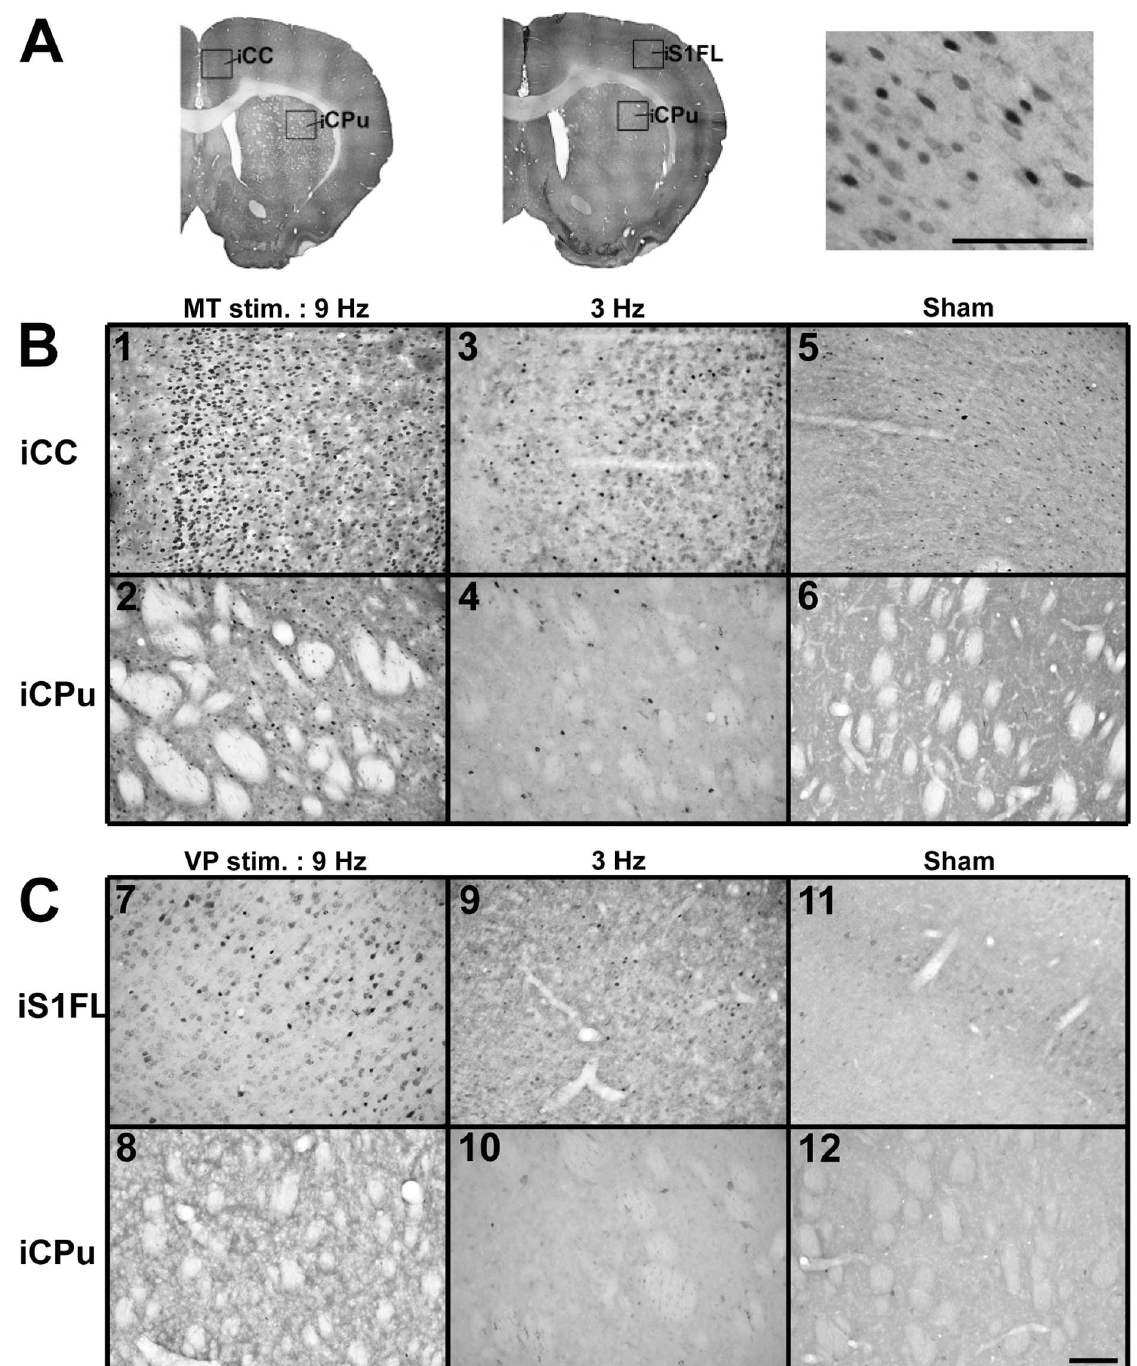
Figure 10. Photomicrographs depicting the distribution of Fos-immunoreactive cells in the brain regions of the iCC, iS1FL and iCPu after MT or VP stimulation. (A) Regions of interest where c-Fos labeled cells were counted. An example of the c-Fos labeled cells is shown in the right panel. (B) Show examples of the c-Fos labeled cells within iCC and iCPu with a 9-Hz (1,2) MT stimulation compare to 3-Hz stimulation (3,4) and sham control (5,6). (C) Examples of c-Fos labeled cells within the iCC and iCPu with 9-Hz (7,8) VP stimulation compared to 3-Hz stimulation (9,10) stimulation and the sham control (11,12). Scale bar=0.1 mm. doi:10.1371/journal.pone.0066821.g010 core of the VP in both rats and monkeys. Nociceptive neurons in neurons are excited by noxious mechanical [47,48] and noxious the VP are excited by noxious or innocuous stimuli [44]. These visceral [49] stimuli, but are usually unresponsive to innocuous neurons often have small contralateral receptive fields that are tactile stimuli. In addition, MT neurons usually have a large organized somatotopically [45,46]. In the MT, nociceptive receptive field, without somatotopical organization, and are often